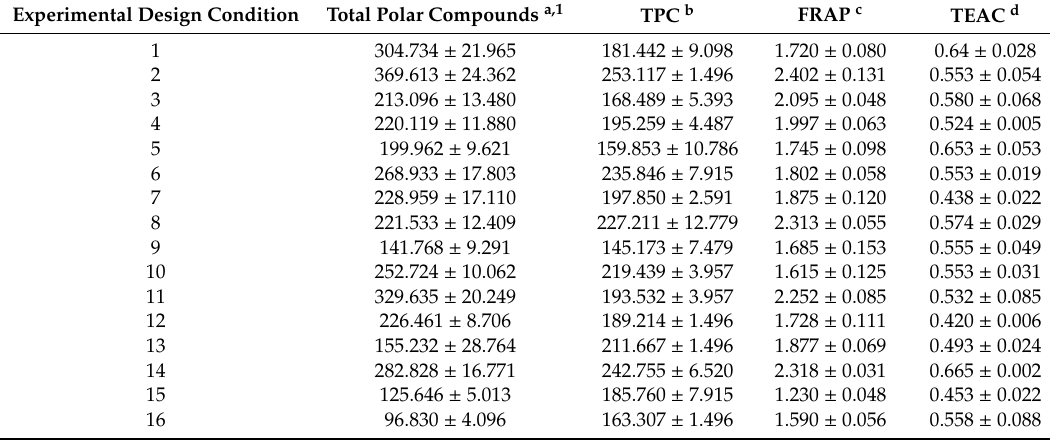
Table 3. Results of the response variables for each condition in L. citriodora . Response variables: Total Polar Compounds, TPC, FRAP and